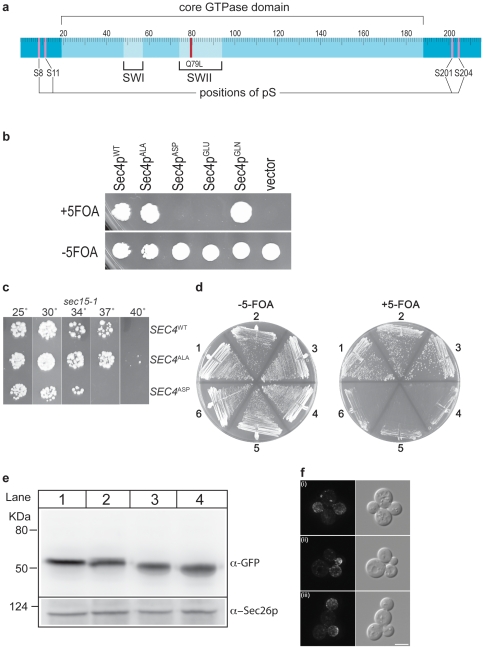
Mutation of Sec4p phosphorylation sites.
a. Schematic of Sec4p. The positions of the nucleotide-dependent conformational switches (SWI, SWII) and the catalytic Q79 residue are shown relative to the positions of the phosphorylated serines (S8, S11, S201, S204). b. Functionality of GFP-tagged Sec4p phosphorylation mutants. Sec4p phosphorylation sites were mutated as described in the text to alanine (Sec4pALA; 8AAAA11
201AINA204), aspartic acid (Sec4pASP; 8DADD11
201DIND204), glutamic acid (Sec4pGLU; 8EAEE11
201EINE204) or glutamine (Sec4pGLN; 8QAQQ11
201QINQ204) residues and transformed into the tester strain along with wild type Sec4p (Sec4pWT; 8SASS11
201SINS204) and vector (pRS315) as positive and negative controls, respectively. Transformants were spotted onto media with (+) or without (−) 5-Fluoroorotic acid (5-FOA) and incubated at 30°C for 3 days. c. Expression of Sec4p mutants without NH2-terminal tag. Cells containing episomal plasmids with the indicated SEC4 constructs as the sole cellular source of SEC4 were tested for growth ability in the sensitized background of sec15-1. d. Sec4p Q79L phosphomimetics are non-functional in sec15-1 cells. Constructs of Sec4pALAQ79L (1), Sec4p Q79L (2), GFP-Sec4p (3), vector (4), Sec4pGLUQ79L (5) and Sec4pASPQ79L (6) were transformed into sec15-1 SEC4Δ cells. Resulting transformants were struck onto media with (+) or without (−) 5-FOA and incubated at 25°C for 3 days. e. Expression of GFP-Sec4p phosphomutants. Cells containing GFP-tagged Sec4p phosphomutants were grown to mid-log phase prior to harvesting. Clarified supernatants of yeast extracts were generated by glass bead lysis, and subjected to SDS-PAGE and Western blot analysis with α-GFP. α-Sec26p was used separately as a lysate loading control. Lane 1 Sec4pGLU, Lane 2 Sec4pASP, Lane 3 Sec4pWT, Lane 4 Sec4pALA. f. Localization of GFP-tagged Sec4p phosphomutants. (i) GFP-Sec4pWT (RCY3122), (ii) GFP-Sec4pASP (RCY3124) (iii) GFP-Sec4pALA (RCY3126) cells were examined by fluorescence microscopy. The Sec4pWT and Sec4pALA constructs were expressed as the sole copy of SEC4. Bar = 5 µm.